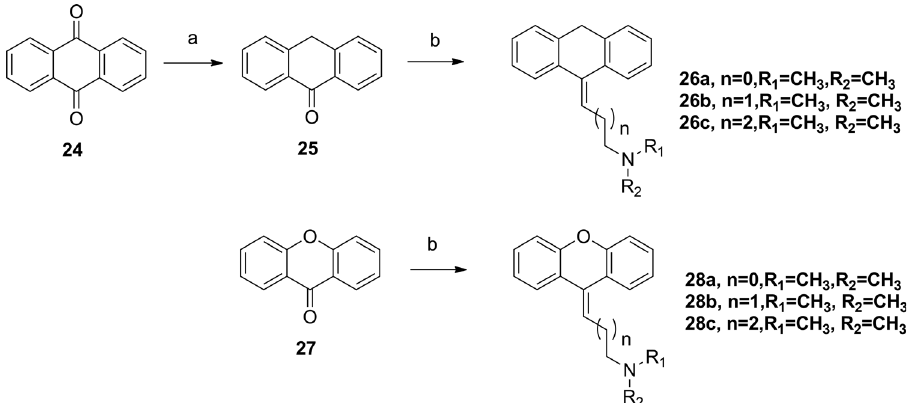
Figure 7. Synthesis of anthracen-9(10H)-ylidene and 9H-xanthen-9-ylidenederivatives. Reagents and conditions: ( a ) SnCl 2 , HCl, AcOH, reflux; ( b ) THF, 10 ,